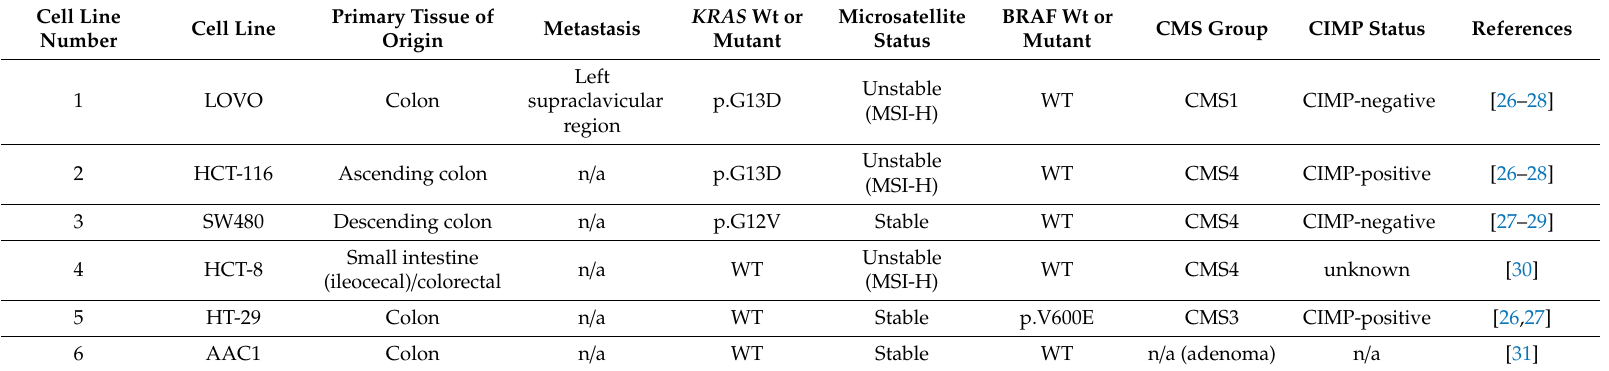
Table 1. Clinical, molecular, and genetic characteristics of cell lines used in this